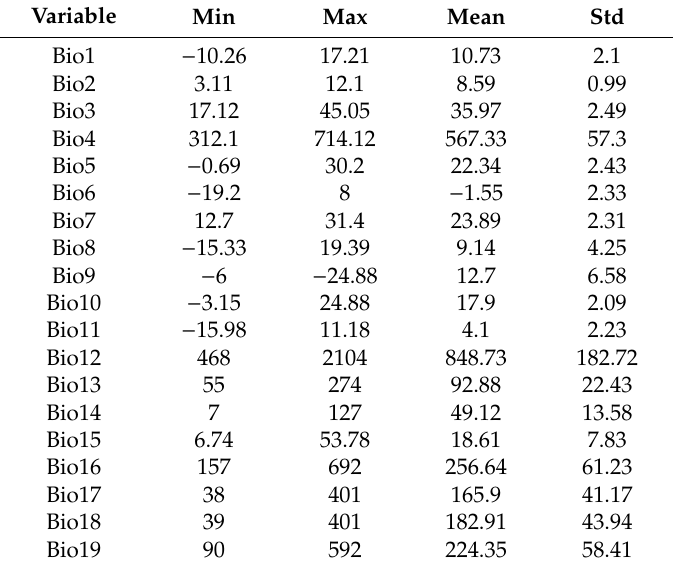
Table A1. 19 Bioclimatic variables of baseline scenario (see Figure 1 for variables names).